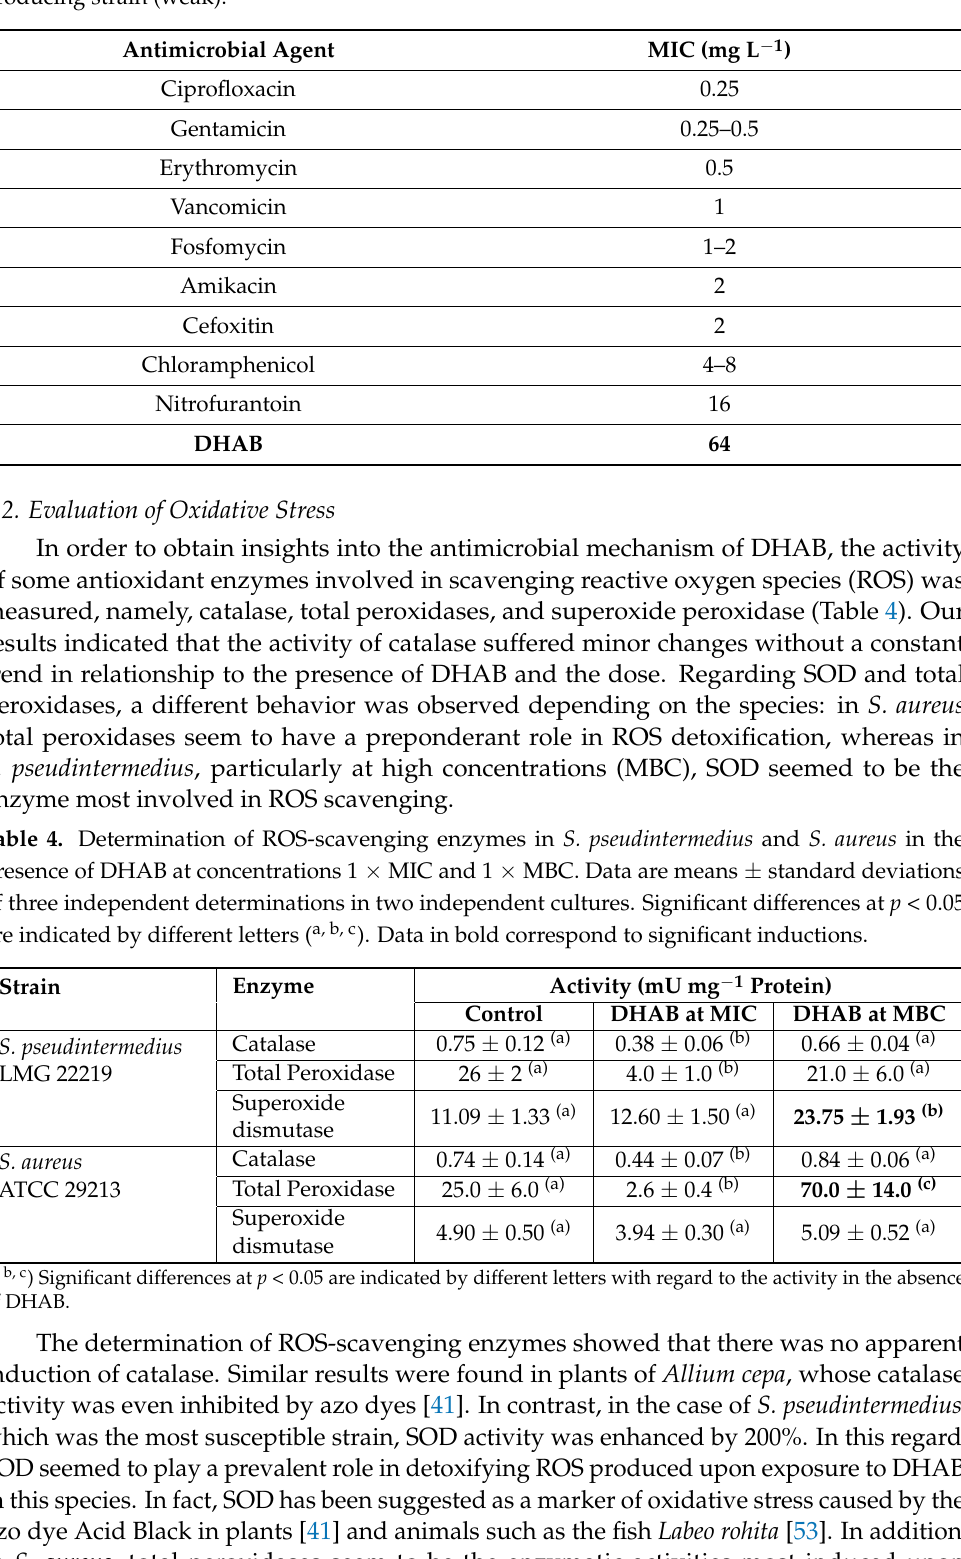
Table 3. EUCAST Breakpoint Table for MIC of Staphylococcus aureus ATCC 29213 β -lactamase- producing strain (weak).